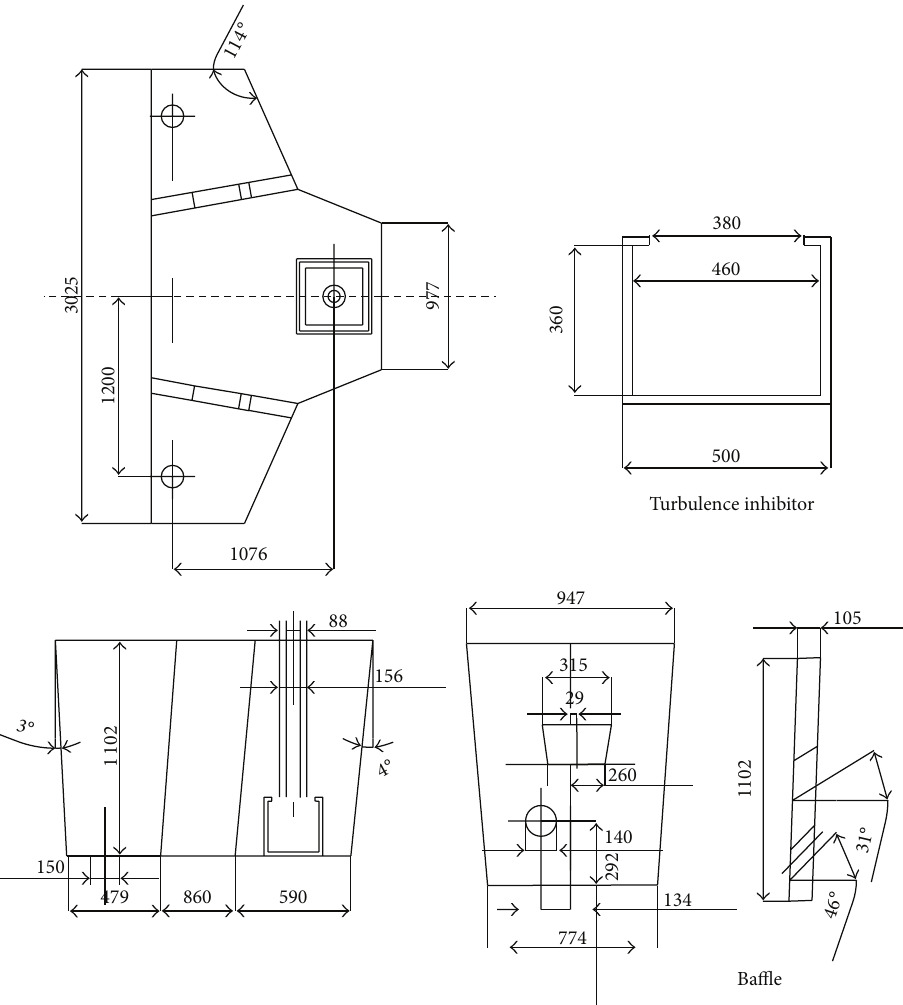
Figure 2: Physical dimensions of the tundish and the control